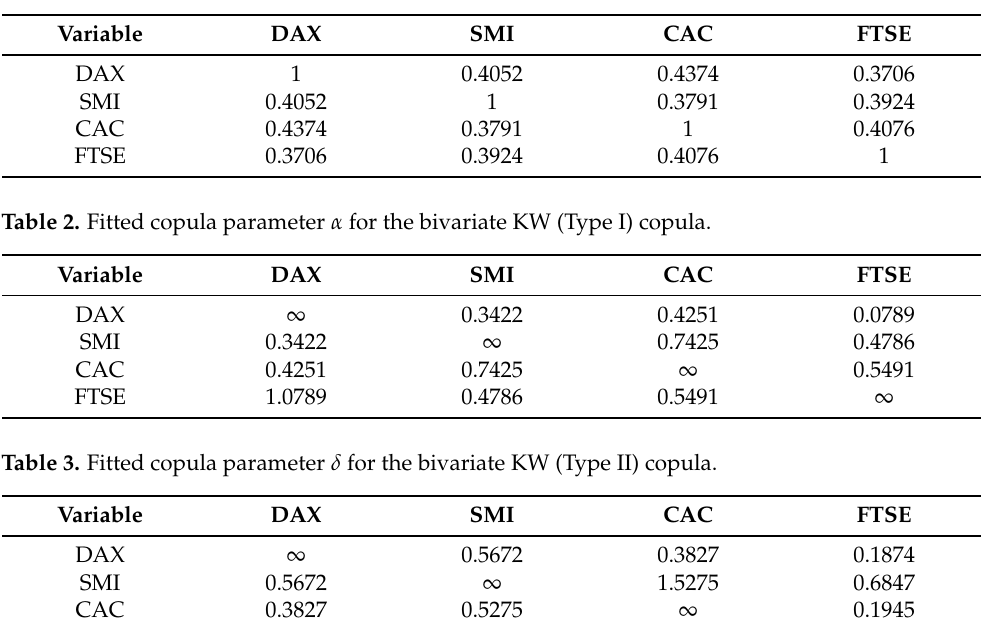
Table 1. Kendall’s tau matrix estimates from four European stock indices returns.